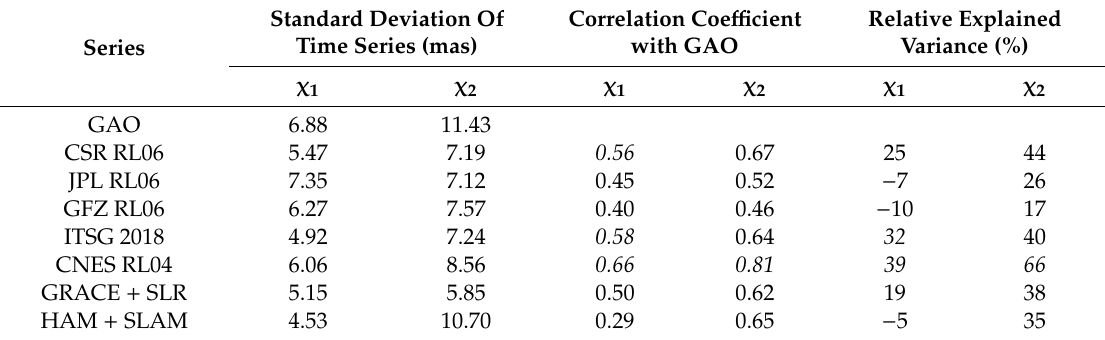
Table 5. Standard deviation of non-seasonal GSMAM, GAO, GRACE + SLR, and HAM + SLAM time series, correlation coe ffi cients with GAO, and percentage of variance in GAO explained by GSMAM, GRACE + SLR, and HAM + SLAM. The critical value of the correlation coe ffi cient for 38 independent points and a confidence level of 0.95 is equal to 0.27. A standard error of a di ff erence between two correlation coe ffi cients for 38 independent points is equal to 0.24. The highest values of correlations and relative explained variances are